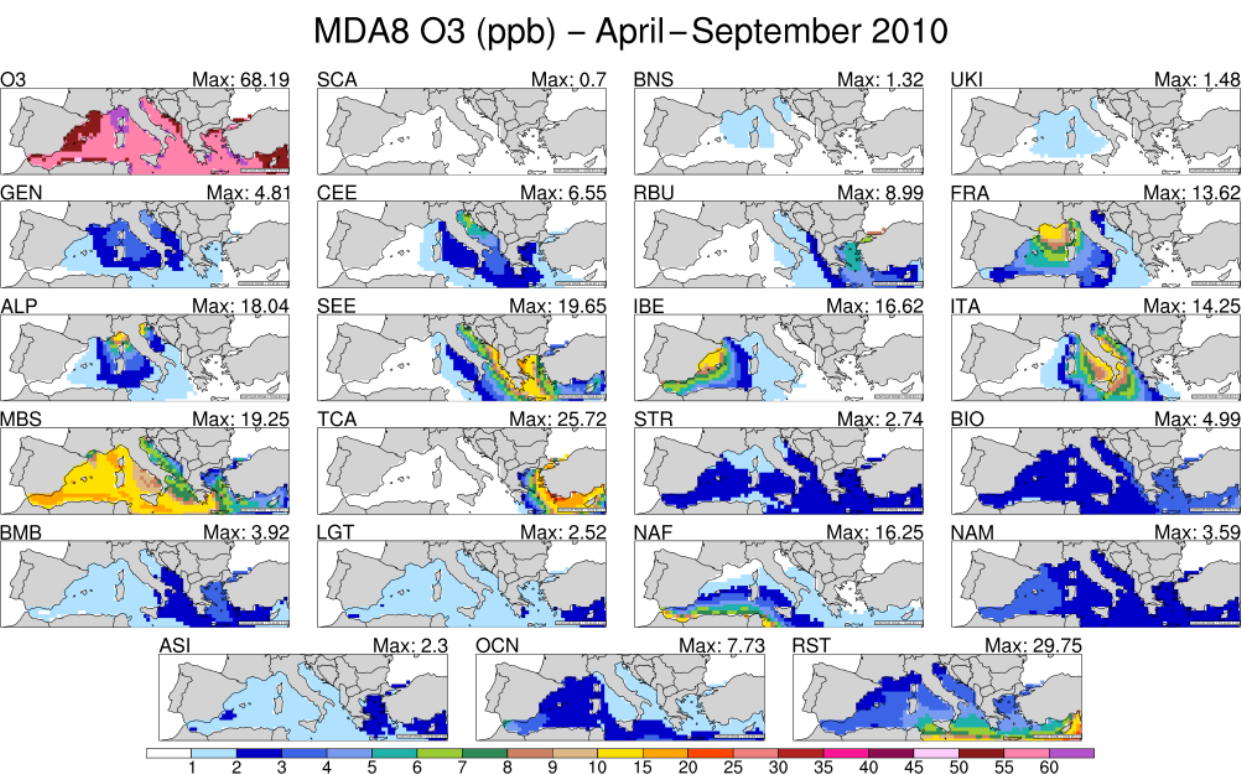
Figure 5. Average MDA8 O 3 mixing ratio (upper left panel) and contribution of each tagged O 3 source region and global source type over the Mediterranean Sea for the April–September 2010 period. The unit is parts per